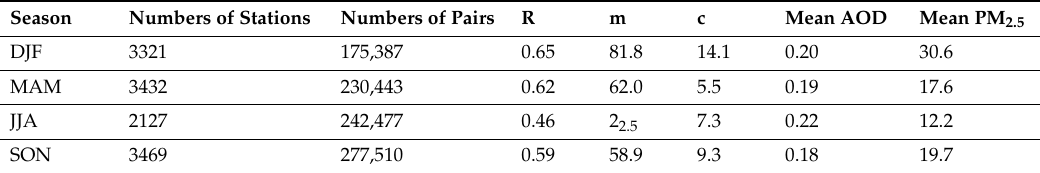
Figure 2. Frequency distribution for five years of ( a ) number of ground monitors by year, ( b ) number of collocated pairs by year, ( c ) satellite AOD in the collocated data, and ( d ) surface PM 2.5 in the collocated data sets. Table 2. Seasonal Distribution of AOD–PM 2.5 statistics for the globe where R, m, and c are linear correlation coe ffi cient, Slope, and Intercept